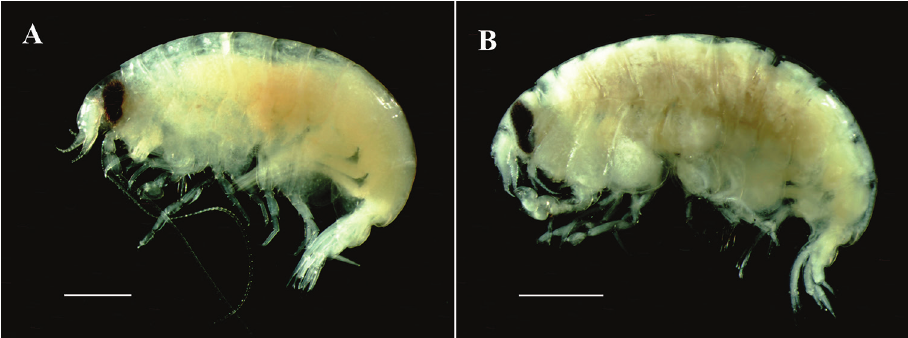
Figure 1. Opisa parvimana sp. nov. A adult male, MARBK-300, 8.3 mm, habitus B adult female, MARBK-301, 7.2 mm, habitus. Scale bars: 1.0 mm ( A, B